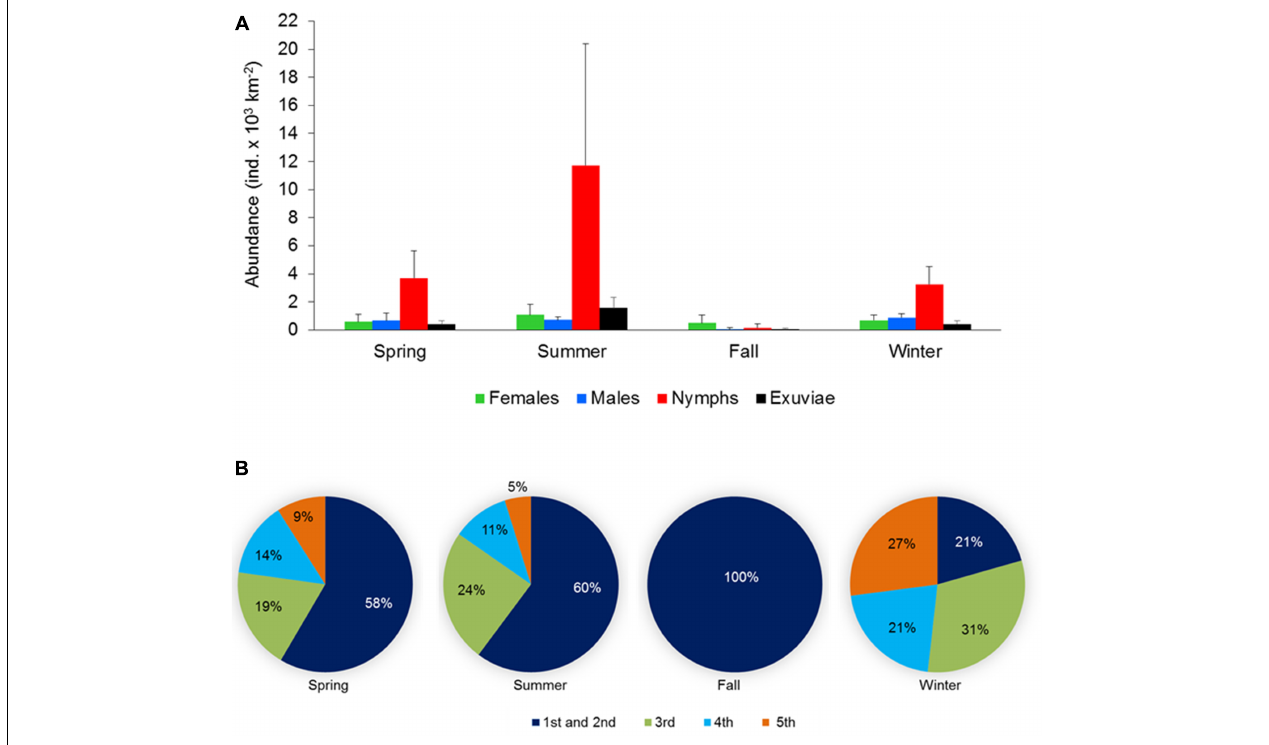
FIGURE 5 | (A) Abundance and population structure (females, males, and nymphs) and exuviae of Halobates germanus and (B) relative contribution of different instar stages to the total nymph population during different season observed at different locations surveyed during the cruises along the north-south extend of the Red Sea during 2016–2018. Error bars indicate standard error of the